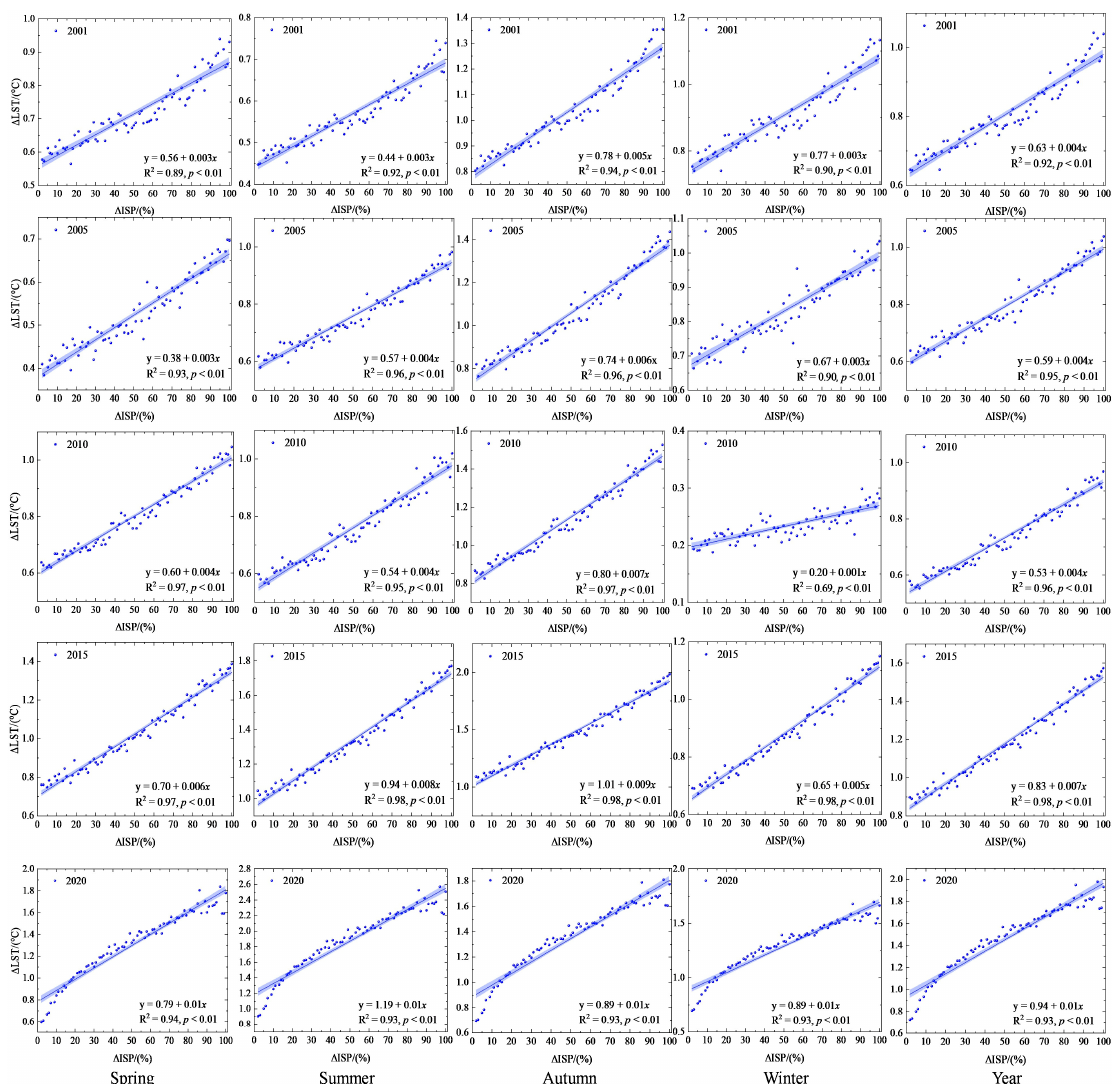
Figure 3. The impact of urbanization on LST during